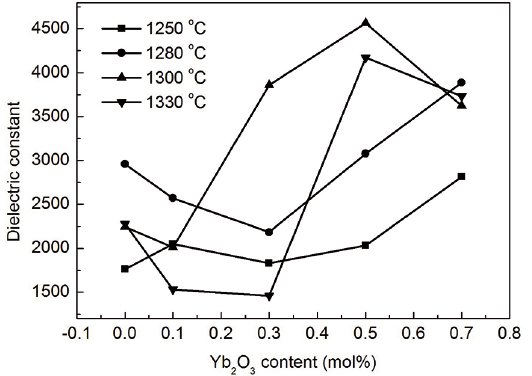
Figure 7: Dielectric constant of BZT10 + x Yb at different temperature.